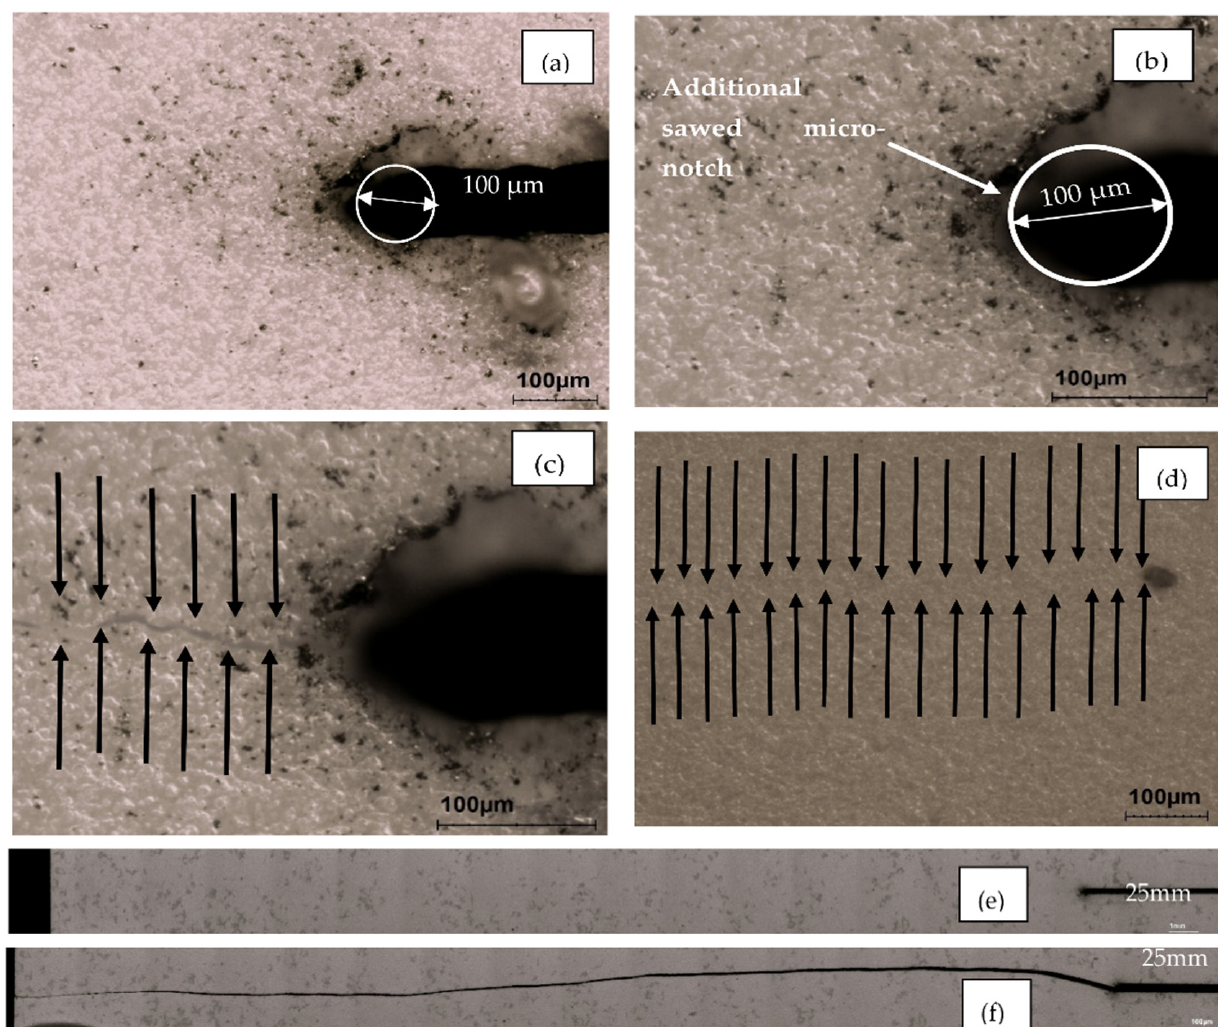
at the laser-cut notch root to facilitate the crack onset and to ensure that the initial cracking takes place in the middle of the ceramic sample (Figure 2b). Figure 2c shows the onset of a crack after the initial loading propagating through the ceramic material starting from the notch and then stopping, as indicated by the black arrows. Figure 2d shows the already initiated crack propagating through the rest of the sample after an increase in the applied load. Figure 2d shows a complete picture of a representative sample (BB05) before and after the DCB testing and the path run by the propagating crack (Figure 2e,f).